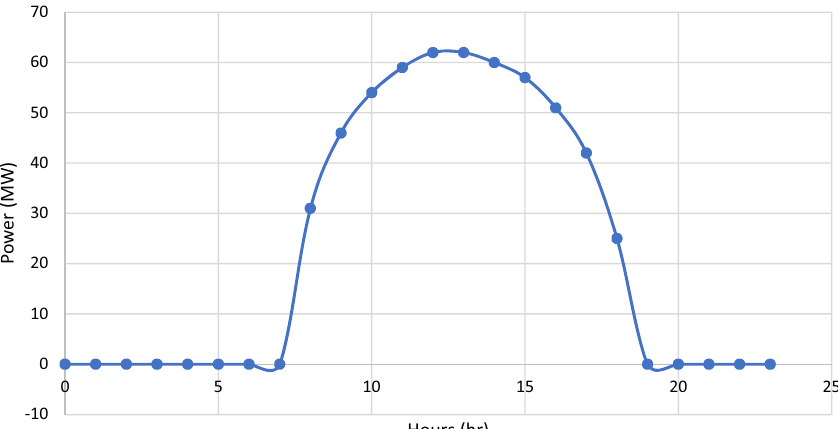
Fig. 4 Annual hourly average of energy injected into the grid in a